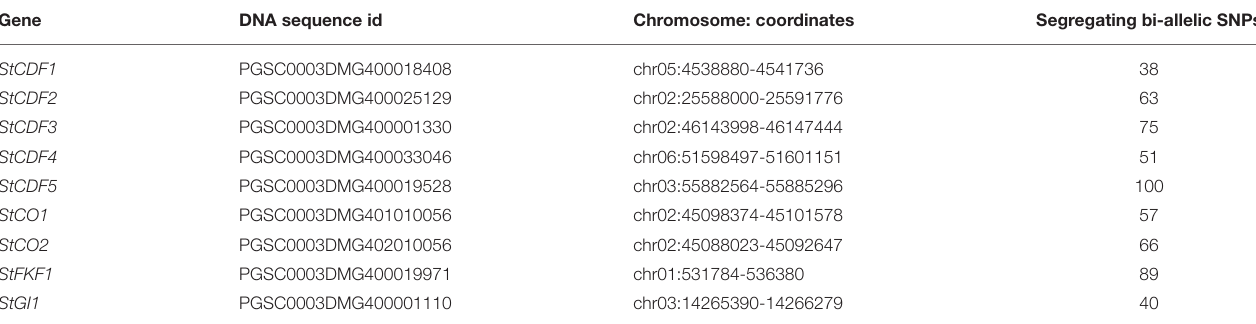
TABLE 1 | S. tuberosum loci selected for haplotyping. Gene DNA sequence id Chromosome: coordinates